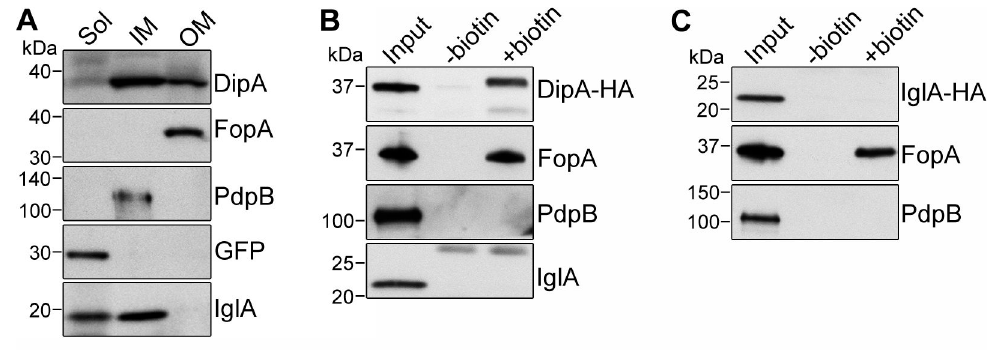
Figure 2. DipA is a surface-exposed, membrane-associated protein. (A) Subcellular localization of DipA, FopA, PdpB, GFP, and IglA from GFP-expressing SchuS4. Soluble (Sol), inner membrane (IM), and outer membrane (OM) enriched fractions were separated based on Sarkosyl solubility and subjected to immunoblot analysis with antibodies against DipA, FopA, PdpB, GFP and IglA. Each fraction was concentrated to the same volume and equal volumes were loaded. GFP, PdpB and FopA were used as soluble, inner membrane and outer membrane markers, respectively. (B and C) Immunoblot analysis of purified surface biotinylated proteins from SchuS4Δ dipA (p dipA-HA ) (B) or SchuS4(p iglA-HA ) (C) lysates. DipA-HA and IglA-HA were detected using anti-HA antibodies. FopA was used as a positive control; PdpB and IglA were used as negative controls. Input, untreated (-biotin) and biotinylated (+biotin) samples were processed for CFU enumeration and immunoblotting as described in Materials and Methods. Samples were loaded based on CFU equivalents as follows: 1x10 7 (Input) or 1x10 8 (-/+ biotin) for anti-DipA-HA analysis, 5x10 6 (Input) or 1x10 8 (-/+ biotin) for anti-FopA analysis, 1x10 7 (Input) or 5x10 8 (-/+ biotin) for anti-PdpB analysis, 1x10 7 (Input) or 5x10 8 (-/+ biotin) for anti-IglA analysis, 1x10 7 (Input) or 5x10 8 (-/+ biotin) for anti-IglA-HA analysis. doi: